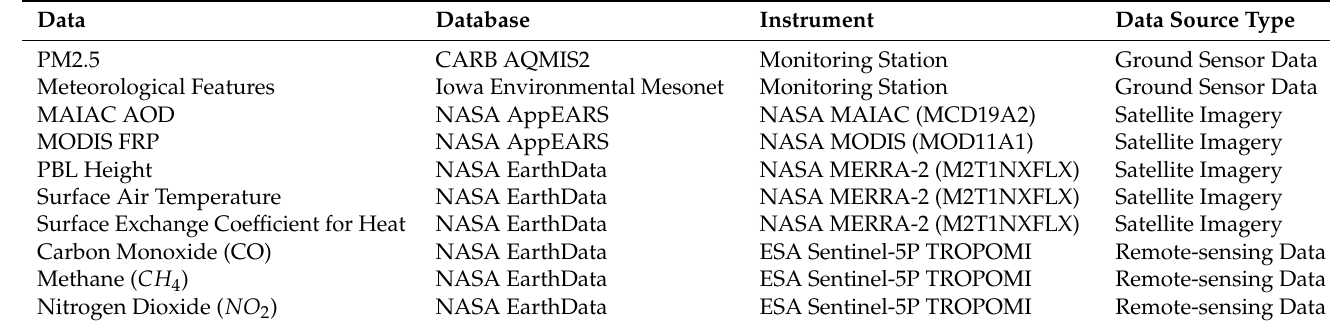
Table A1. Data summary table of input data source databases, instruments, and data source types.